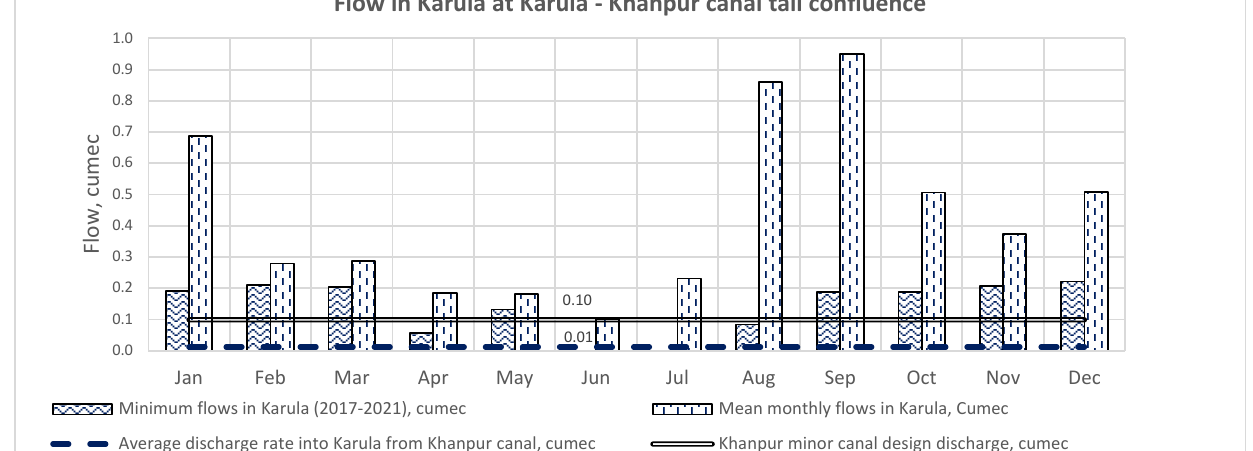
Figure 6. A snapshot of flow regime in Karula river and saved water from Khanpur Minor canal being discharged into Karula river.